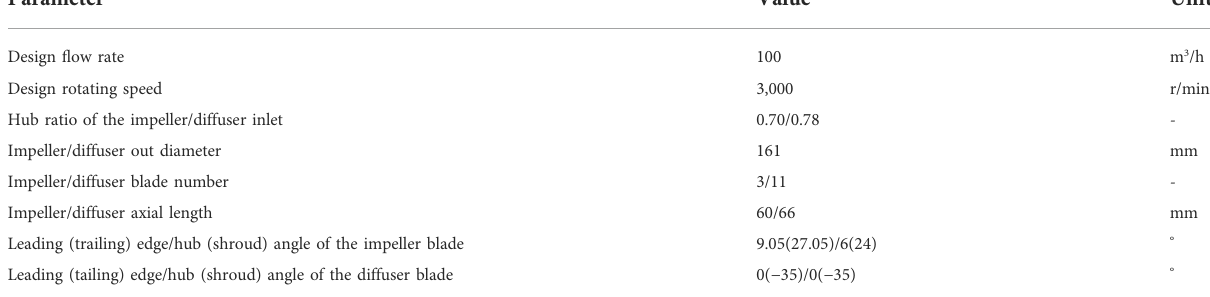
TABLE 1 Main performance parameters of the multiphase